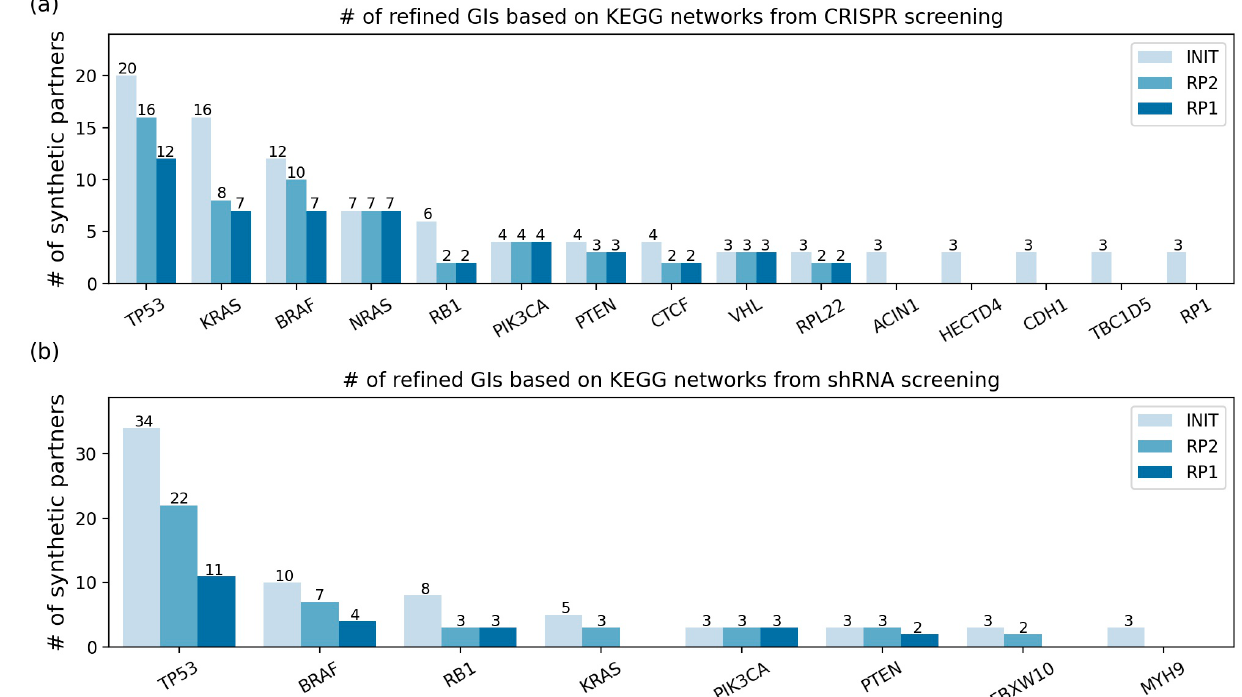
Figure 3. The number of GIs for each mutated gene refined based on KEGG networks from: ( a ) CRISPR screening and ( b ) shRNA screening. Among all results, only the mutated genes that had three or more initial GIs are presented. The x -axis indicates each mutated gene. INIT: the initial GIs after mapping on the KEGG networks (no RP was applied). RP2: GIs after applying the RP with a distance of 2 to the initial GIs. RP1: GIs after applying the RP with a distance of 1 to the initial GIs. RP: refining process.